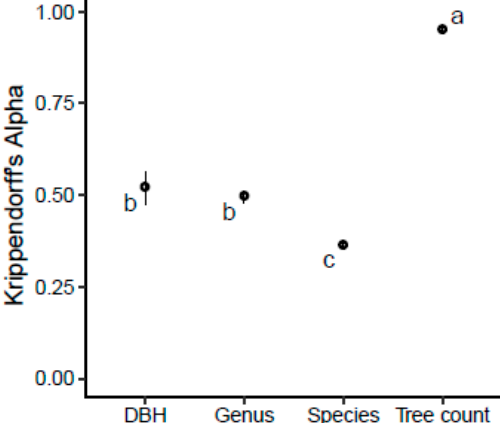
Figure 1. Krippendorff’s alpha scores summarizing interrater agreement among all analysts for all variables, with 95% confidence intervals. Different letters indicate significantly different analyst agreement.